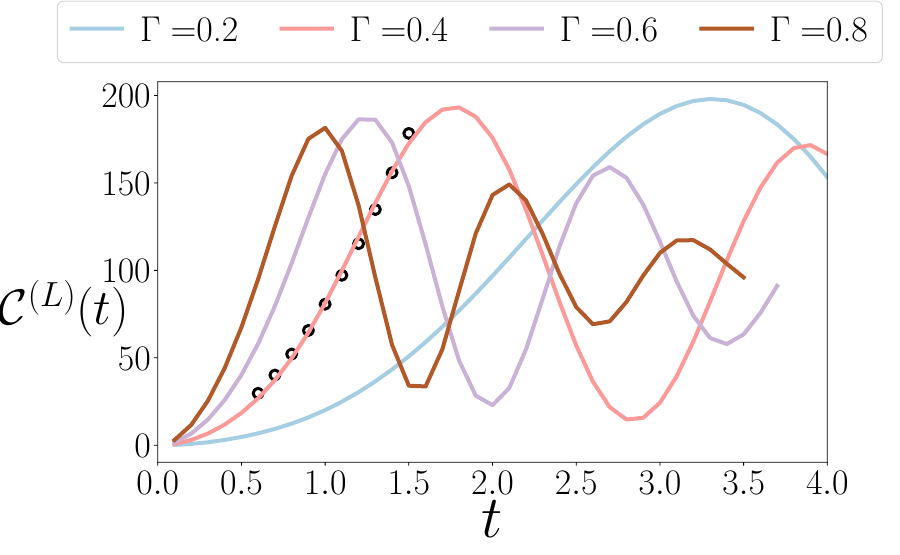
Figure 10: The commutator obtained from DOTOC ( c ( L ) ( t ) ) for varying Γ ’s. The black circles show a typical fit made in the increasing ramp